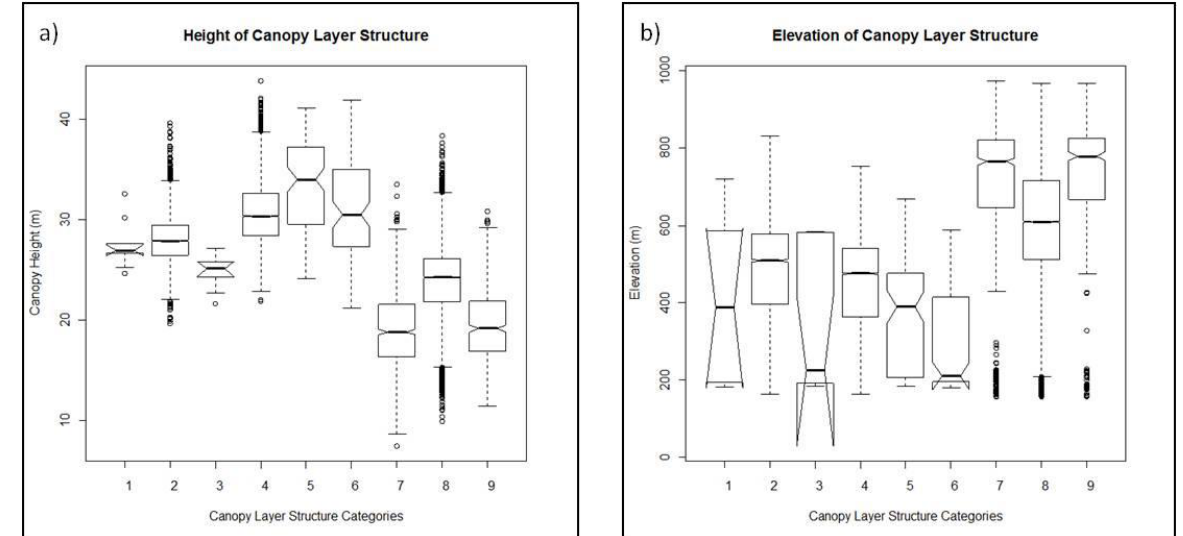
Figure 8. Canopy height ( a ) and elevation ( b ) distribution for each category of canopy layer structure. Boxes represent the interquartile range, with whiskers defining the range of heights within 1.5 times the upper and lower quartiles. The open circles depict outliers. The median canopy heights differ between most of canopy layer structure categories at roughly the 95% confidence level, as shown by the lack of overlap between notches on the box plots. The small sample size of categories 1, 3, and 6 caused the confidence of the median to be calculated larger than the data range, as depicted by the extended notches on the